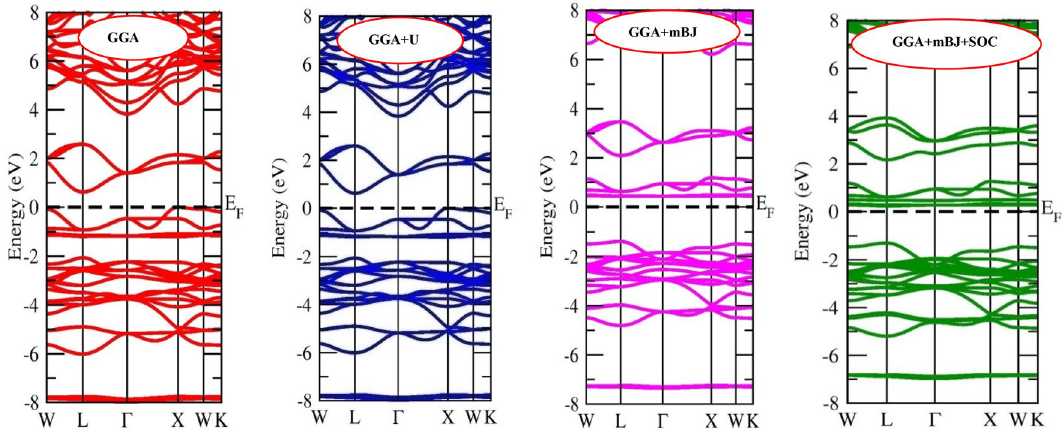
Figure 2. Band structure of Cs 2 CuSbCl 6 calculated by GGA, GGA + U and GGA + mBJ and GGA + mBJ + SOC methods.